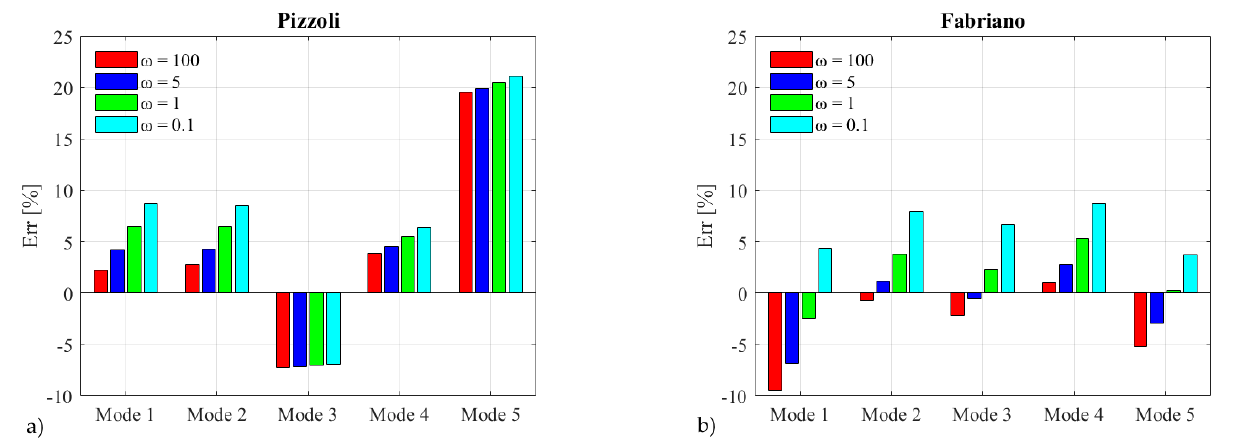
Figure 21. Errors on the estimate of natural frequencies of first five modes varying the ω value from 100 to 0.1: ( a ) Pizzoli’s town hall; ( b ) former Fabriano courthouse.